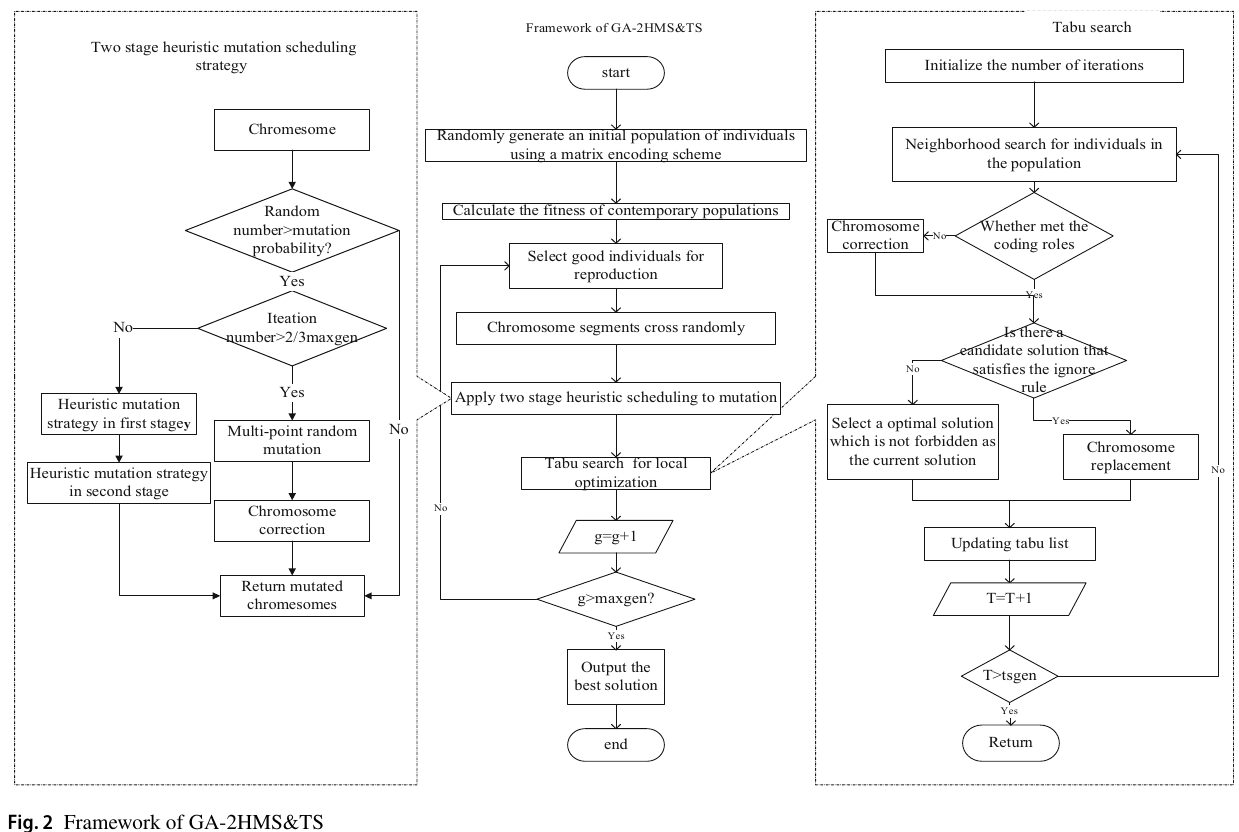
Fig. 2 Framework of